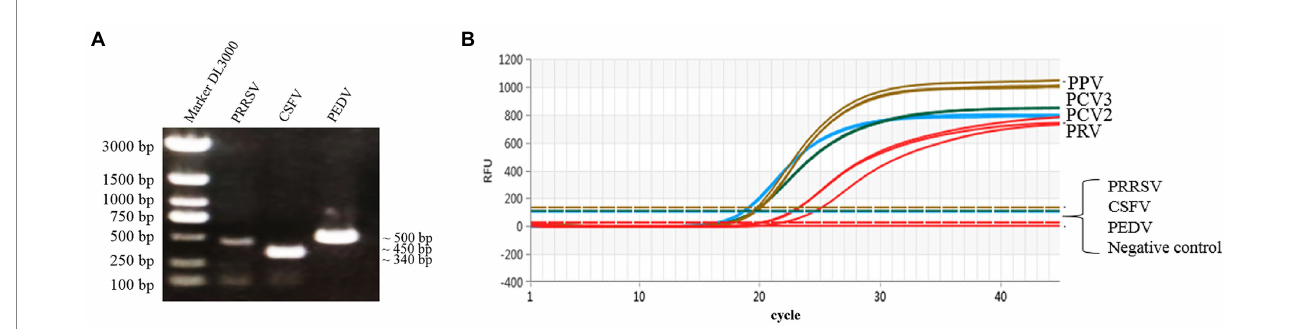
FIGURE 4 Specific amplification curves by multiplex real-time PCR assay. (A) Agarose gel electrophoresis of viral replicons (PRRSV, CSFV, and PEDV) amplified by PCR. Lane 1 represents the 3,000-bp marker, Lanes 2–4 represent PRRSV (451 bp), CSFV (343 bp) and PEDV (503 bp), respectively. (B) Four fluorescent signals were monitored by multiplex real-time PCR, and DNA of PCV2, PCV3, PPV, and PRV were used as a positive control. No fluorescent signal was observed when other viral cDNAs were used as templates. Note: The graph type was set as in linear phase to simultaneously display the four different fluorescent signals (FAM, VIC, ROX, and Cy5) with distinct signal intensities.